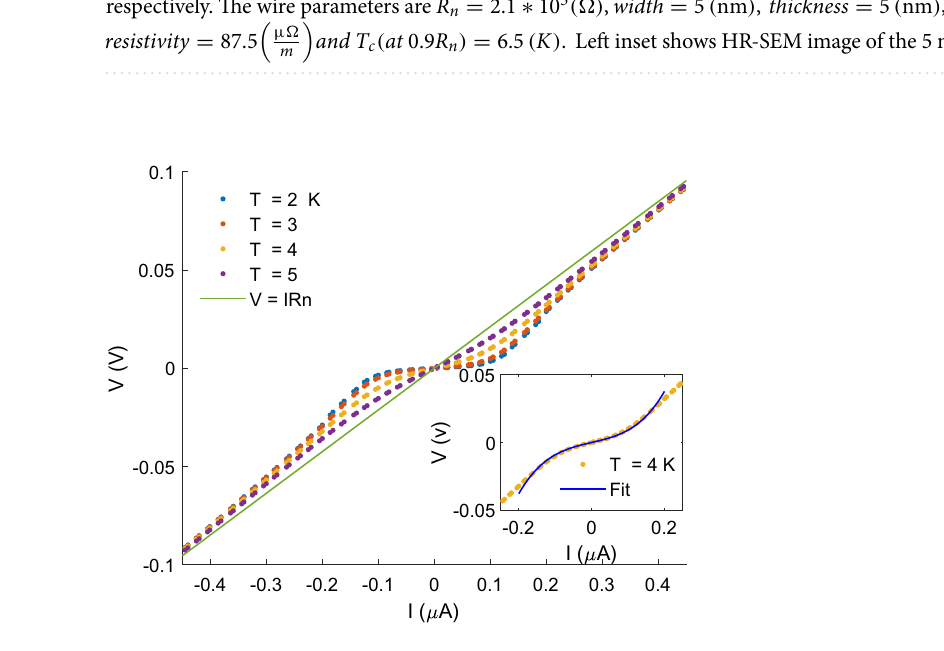
Figure 2. Voltage vs. current for the NbN nanowire at the indicated temperatures. The solid line indicates the Ohmic behavior above T c . Inset: Fit of Eq. (1) to the data at 4